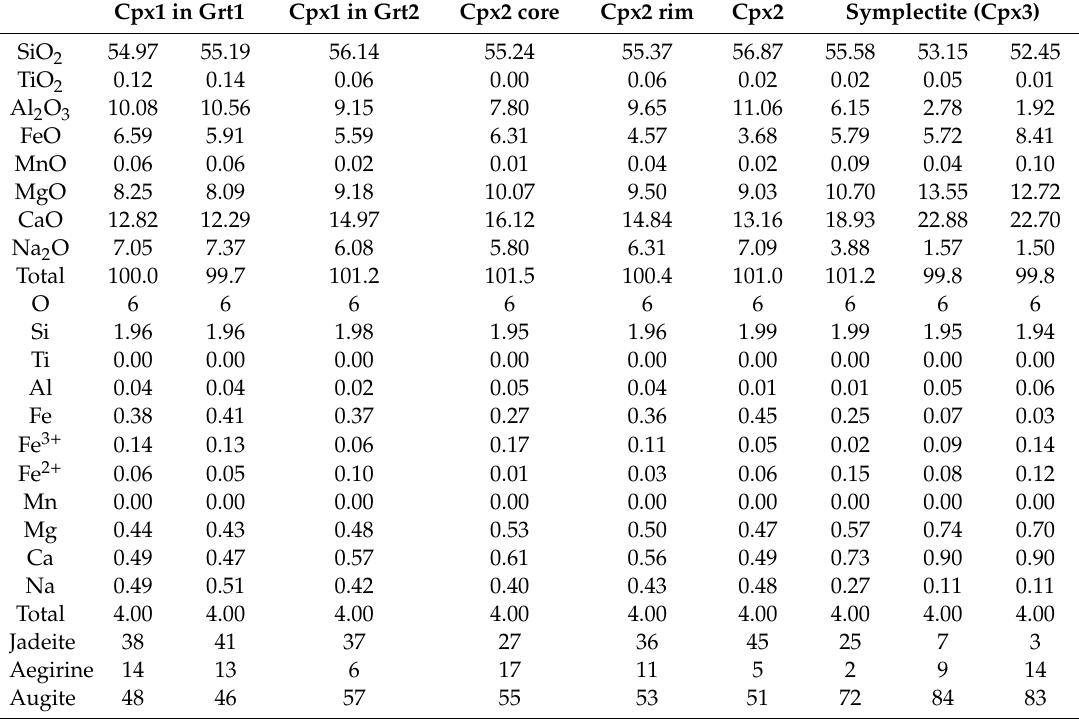
Representative chemical compositions of clinopyroxenes from the eclogites and amphibolitized